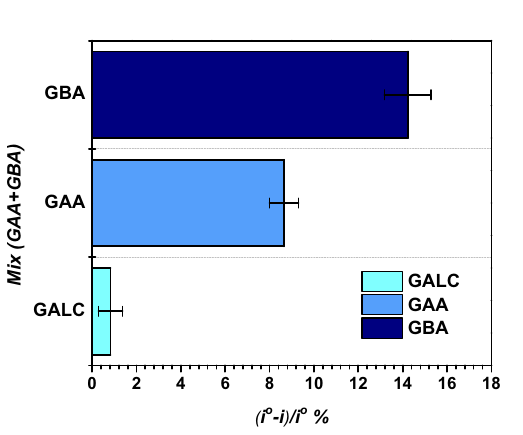
Figure 6. Immunosensor’s responses to 0.5 ng/ml to GAA, GBA, GALC and BSA. Error bars represent SD of the measurements.